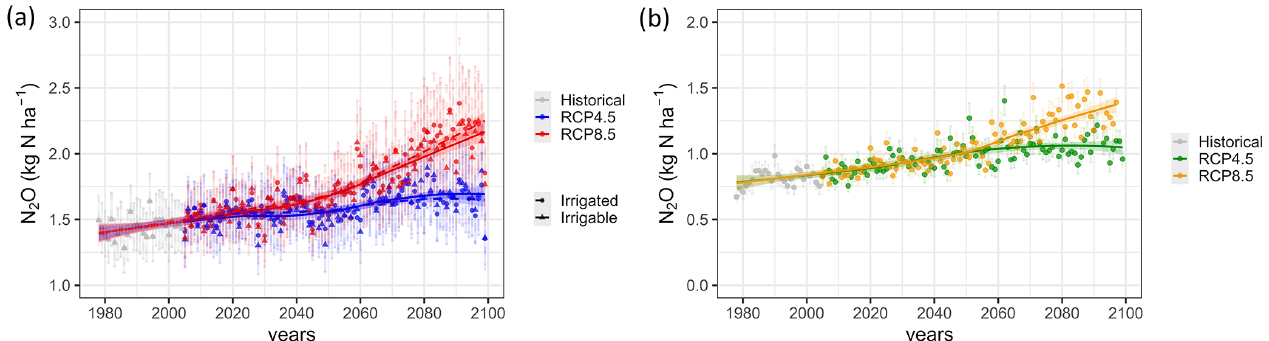
Figure 4. N 2 O emissions (kgNha − 1 yr − 1 ) for (a) croplands and (b) grassland with two climate change scenarios (RCP4.5 and RCP8.5). N 2 O emissions for croplands consider two irrigation conditions, following the irrigable agricultural area in Europe or extending the irrigation to all the arable lands (i_RCP4.5 and i_RCP8.5).